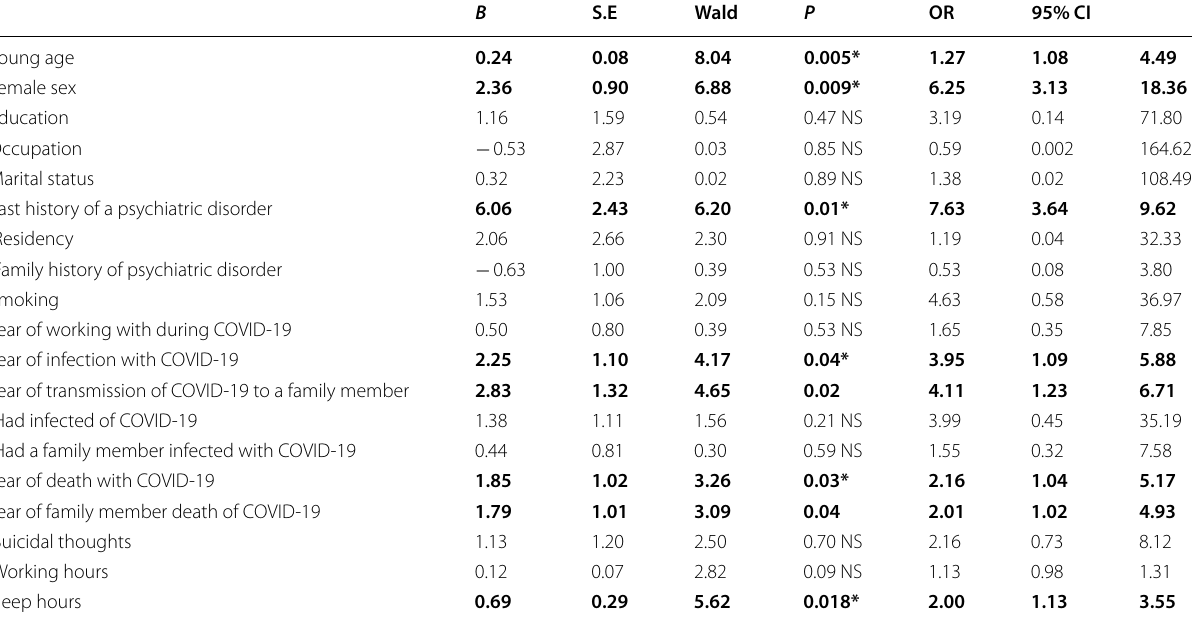
Bold values highlight the significant results NS non-significant ( P >